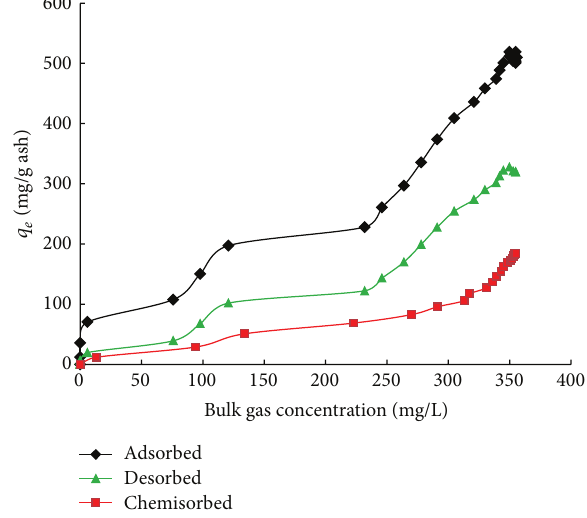
Figure 8: Effect of initial CO 2 concentration on the amount of CO 2 adsorbed, desorbed, and chemisorbed. Reaction conditions: CO 2 /N 2 flow rate of 0.3 L/min, 1.5 g ash, 20% RH, and 22 ∘